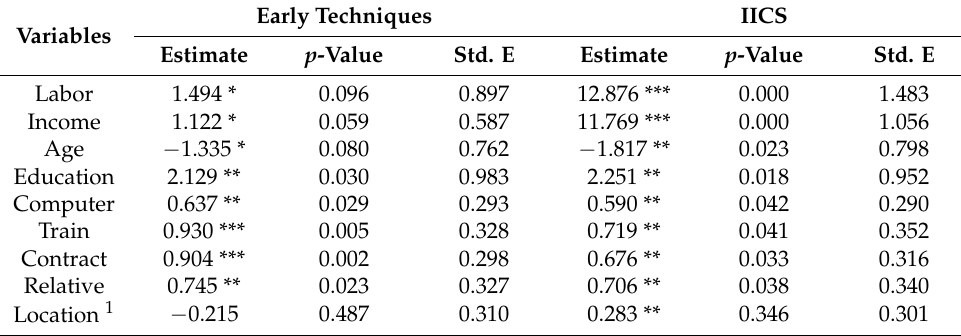
Table 9. Impact of geographical